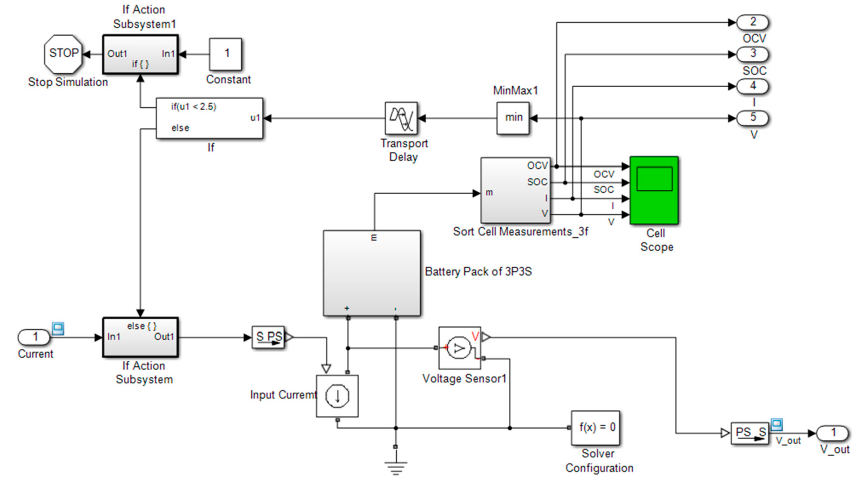
Figure 7. The simulation system of a battery pack.